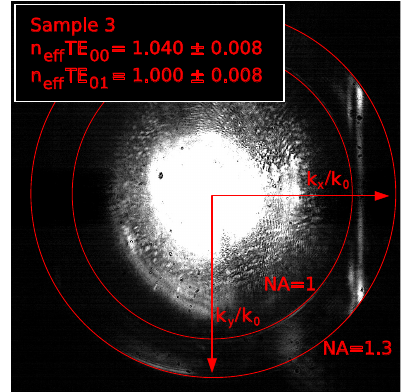
Figure 5. BFP image of sample 3. Two marked red concentric circles define the light line in air (inner) and NA of the collecting objective (external).